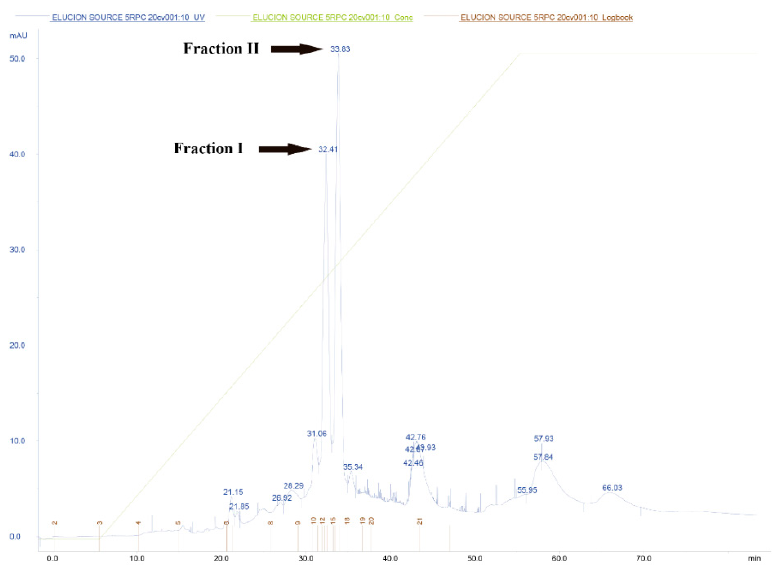
Figure 2. Final RP-FPLC of the multi-chromatographic procedure 2 used to purify NisZ from L. lactis